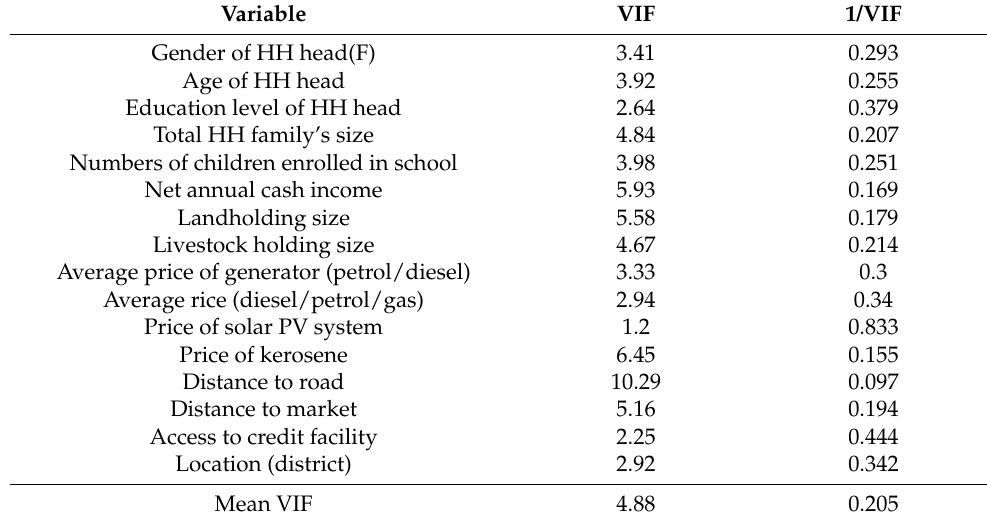
Table 5. Variance inflation factor results.